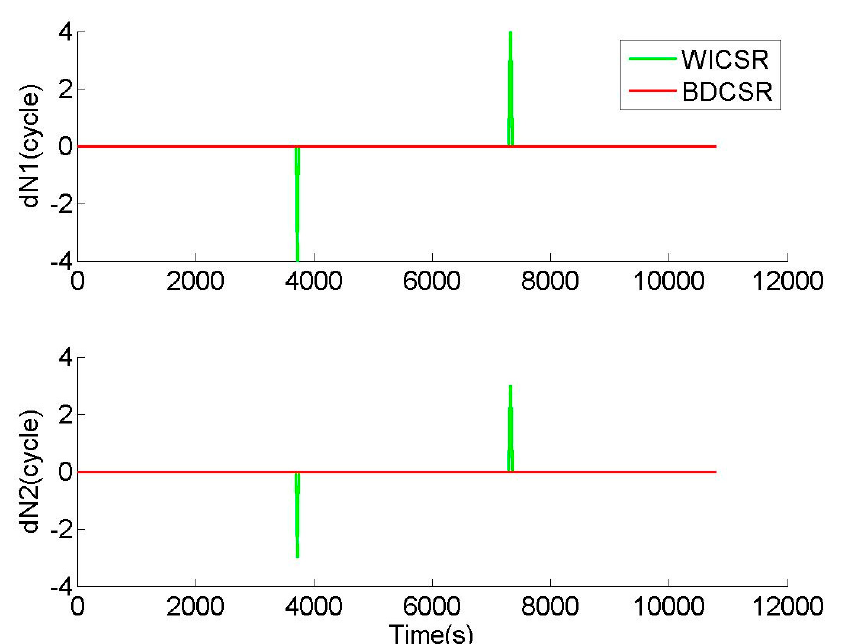
Figure 4. The original cycle slips without correcting the ionospheric variations (WICSR) and those of the BDCSR methodology after correcting the ionospheric variations, where the BDS dual- frequency pseudoranges and phases without cycle slip were collected from the GEO Satellite 2 during the geomagnetic storm, started from UTC 8 May 2016 00:00:00 with an interval of 30 s at the CUT0 station.